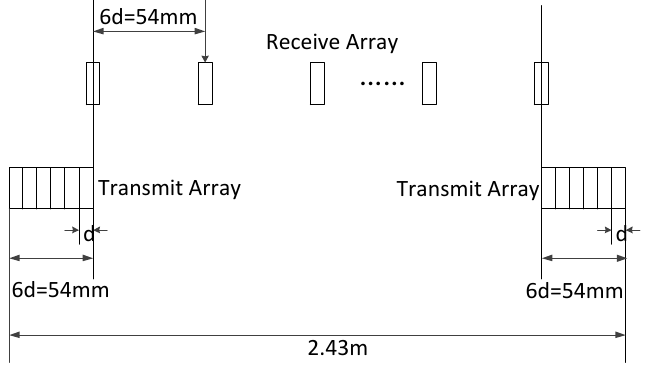
Figure 10. Structure of MIMO array in simulations. Table 1. Parameters of simulations.